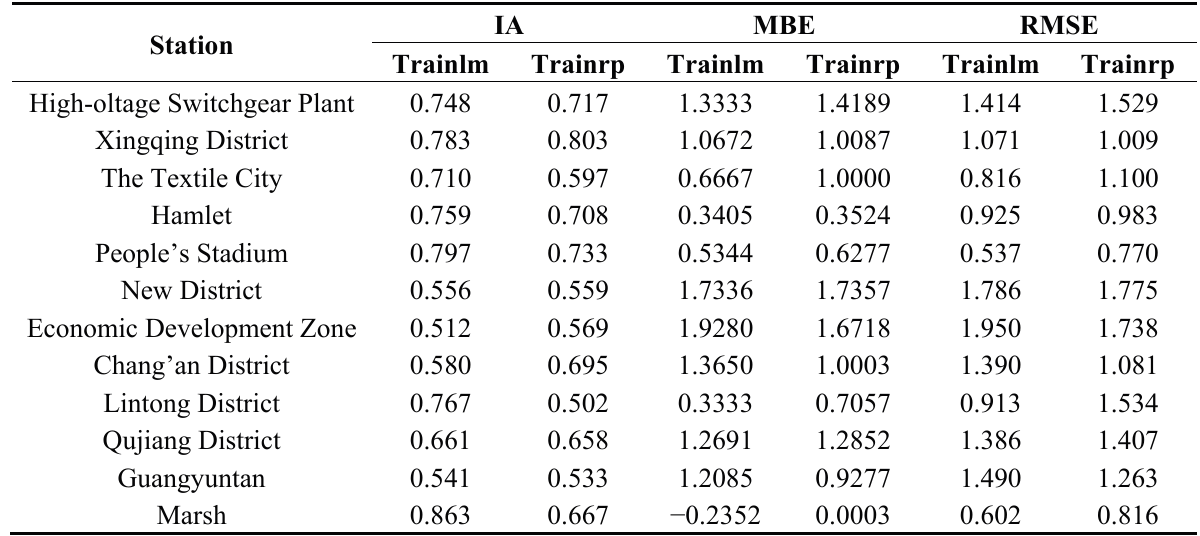
Table 3. Evaluation of the forecasting accuracy for PM2.5